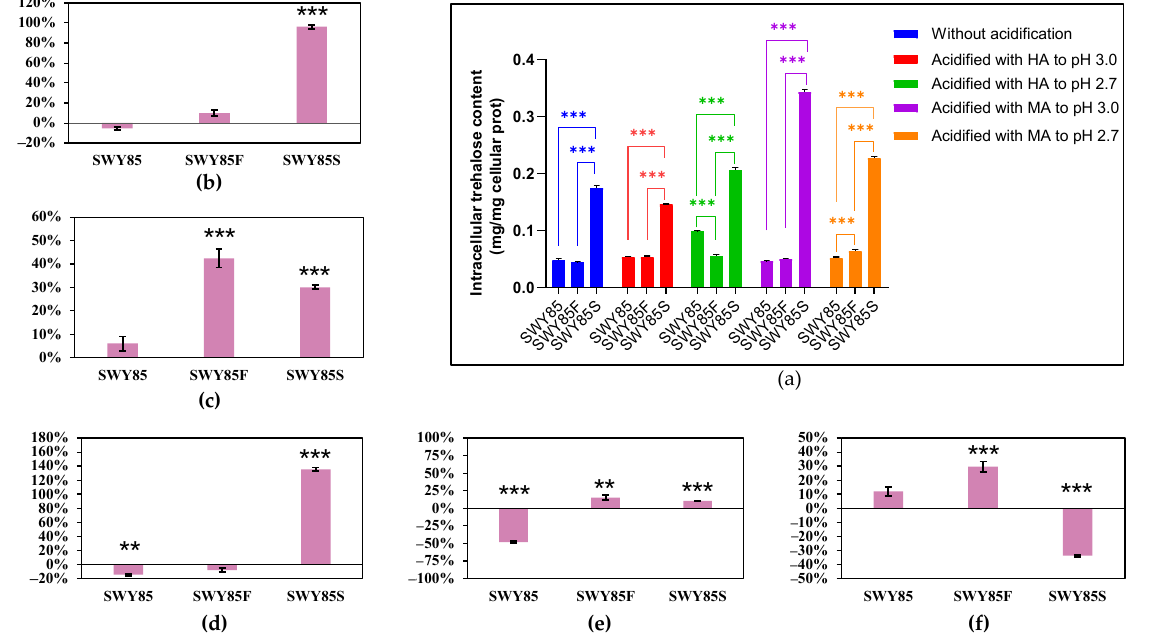
−−−−− Figure 5. The accumulated intracellular trehalose in the wild-type strain and the derivatives cultured under different acid stresses combined with amino acid starvation ( a ), and the variations of intracel- lular trehalose content in three strains cultured in SD medium between different acid stresses (from non-acidification to acidification with malic acid to pH 3.0 ( b ) and to pH 2.7( c ), from acidification with malic acid to acidification with hydrochloric acid at pH 3.0 ( d ) and at pH 2.7 ( e ), and from malic acid stress at pH 3.0 to malic acid stress at pH 2.7 ( f ), respectively.) HA, Hydrochloric acid; MA, Malic acid. ** p < 0.01, *** p < 0.001.